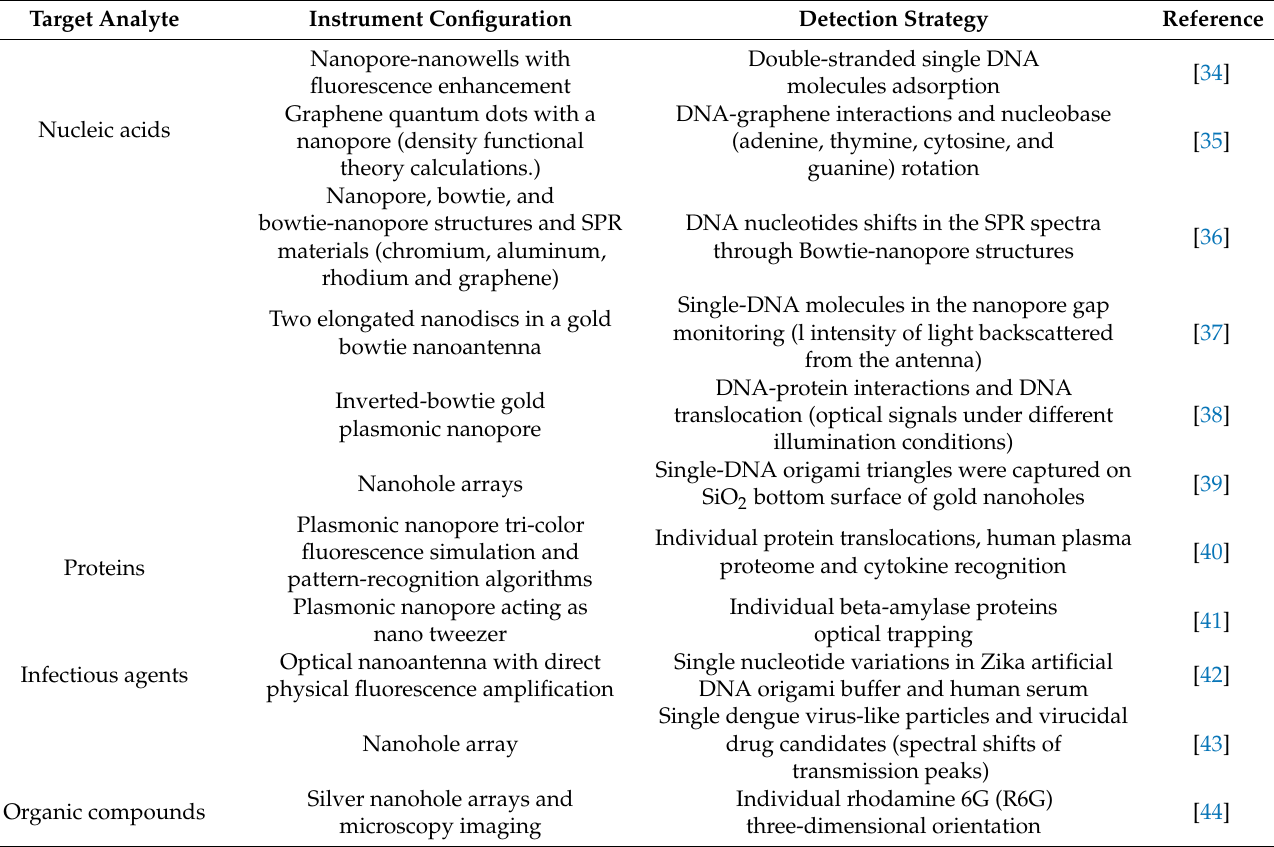
Table 1. Key analytical features of plasmonic applications based on nanopores and nanohole arrays sensors classified according to the characteristics of target analyte, instrument configuration (namely sensing scheme or biological receptor) and detection